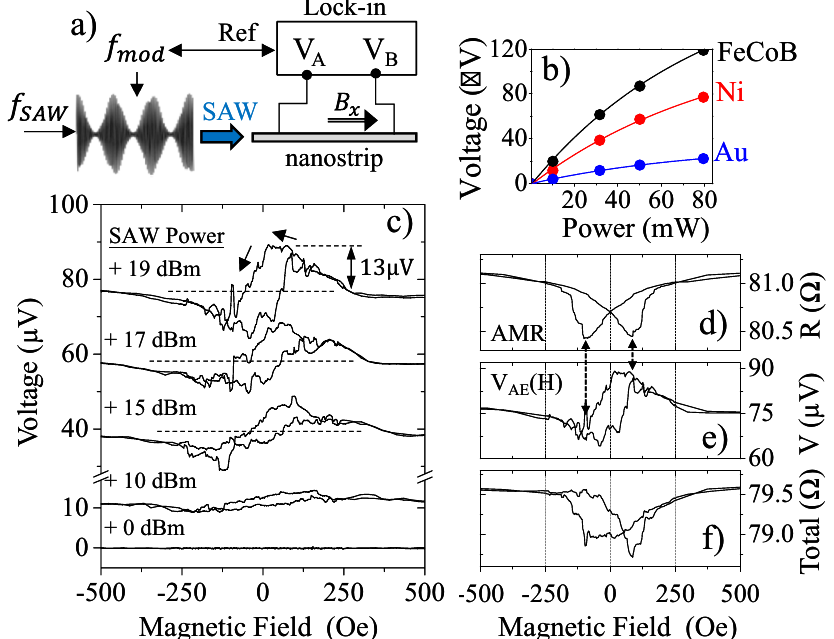
Figure 3. ( a ) Experimental set-up used to measure the acoustic voltage induced by the SAW, using no electric current. ( b ) Voltage induced in three different nanostrips of similar dimensions but made out of different materials, using the experimental set-up described in ( a ). The resistance of the nanostrips is 15 Ω, 80 Ω and 112 Ω for Gold, Nickel and FeCoB, respectively. A 2 nm layer of Pt caps the two ferromagnetic nanostrips. ( c ) Magnetoelastic voltage measured using the set-up described in ( a ) versus external magnetic field for different powers of the SAW. ( d ) AMR loop for no SAW, the same curve as in Fig. 1b. ( e ) Magnetoelastic voltage for 19 dBm, the same curve as the top one in ( c ). ( f ) Sum of the curve in ( d ) and ( e ), turning first ( e ) into resistance by dividing the data by the current used in the AMR measurement, − 50 µ A